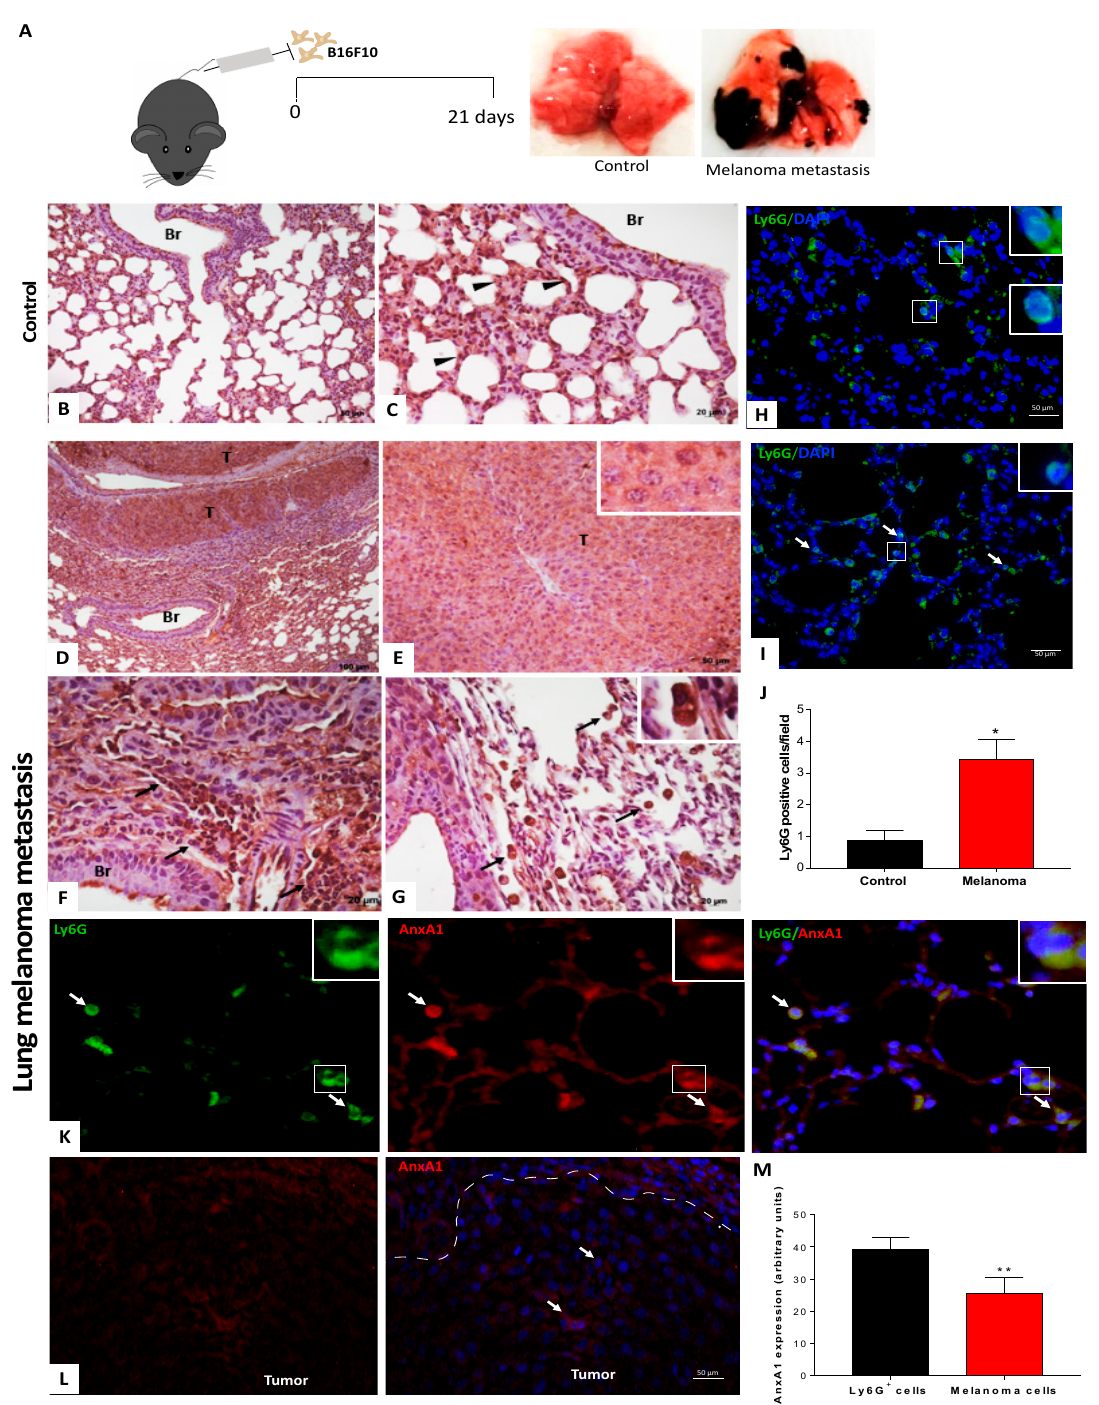
Figure 2. Increased expression and serum levels of AnxA1 in lung melanoma metastasis mice. ( A ) Experimental design. ( B , C ) Control group. Alveolar epithelium (arrowhead). Bronchiolar epithe ‐ lium (Br). ( D , E ) Expression of AnxA1 in melanoma cells (T) from lung melanoma metastasis. ( F , G ) Immune cells labeled for AnxA1. Immune cells infiltrate (arrows). Inserts: Tumor and im- mune cells. Ly6G-positive cells in ( H ) control and ( I ) melanoma groups. ( J ) Increased number of neutrophils in lung melanoma metastasis mice. ( K ) AnxA1 expression in neutrophils (Ly6G + ) and ( L ) in melanoma cells from lung melanoma metastasis. ( M ) Amounts of AnxA1 expression in neu- trophils and melanoma cells. The data represent the average ± SEM of at least 3–5 animals per group. p * < 0.05 vs. control; ** p < 0.01 vs.